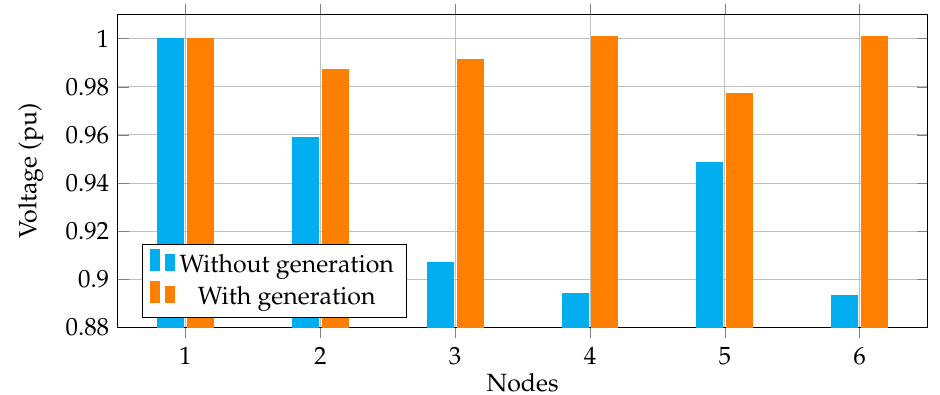
Figure 3. Voltage profiles for the six-bus system when dispersed generation is or is not